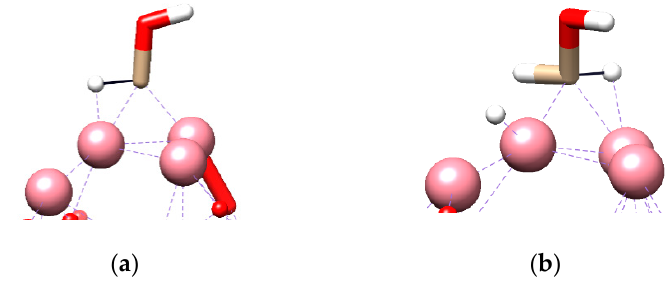
Figure 6. The optimized structures of I-4 ( a ) and I-5 ( b ).